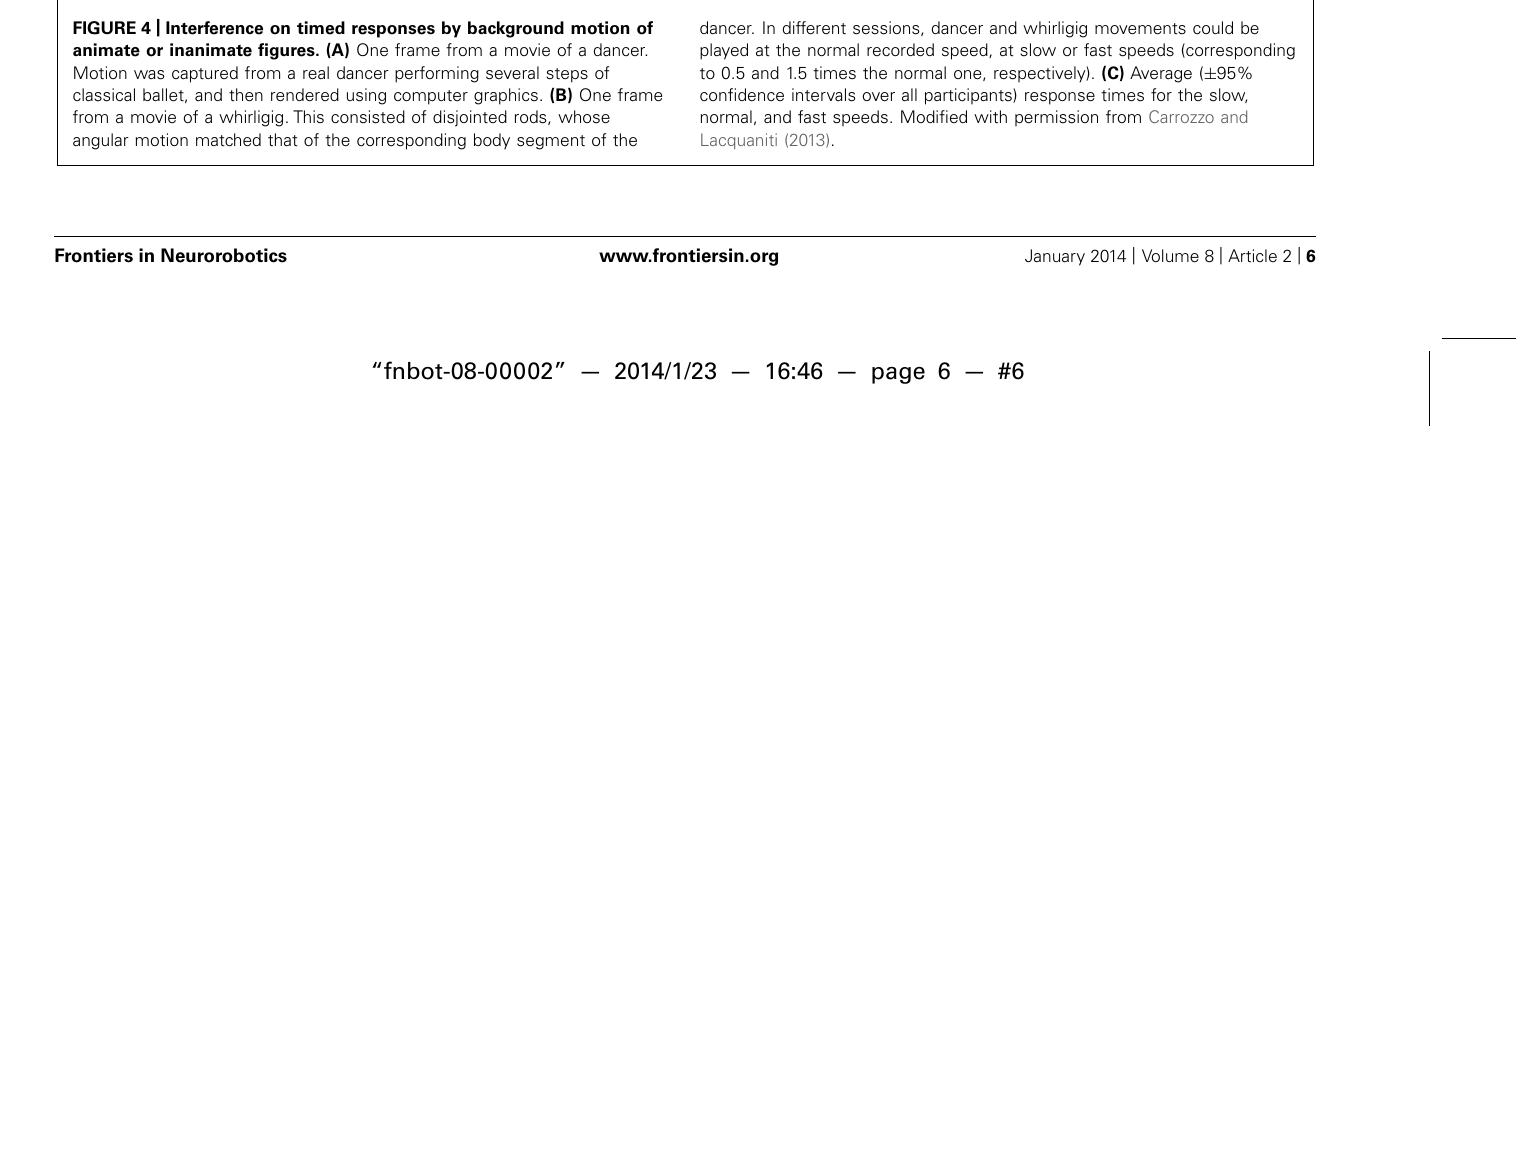
FIGURE 4 | Interference on timed responses by background motion of animate or inanimate figures. (A) One frame from a movie of a dancer. Motion was captured from a real dancer performing several steps of classical ballet, and then rendered using computer graphics. (B) One frame from a movie of a whirligig. This consisted of disjointed rods, whose angular motion matched that of the corresponding body segment of the